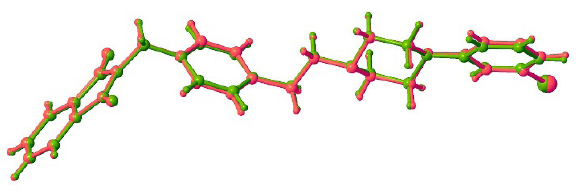
Figure 6: Overlay of the SXRD (green) and PXRD (red)